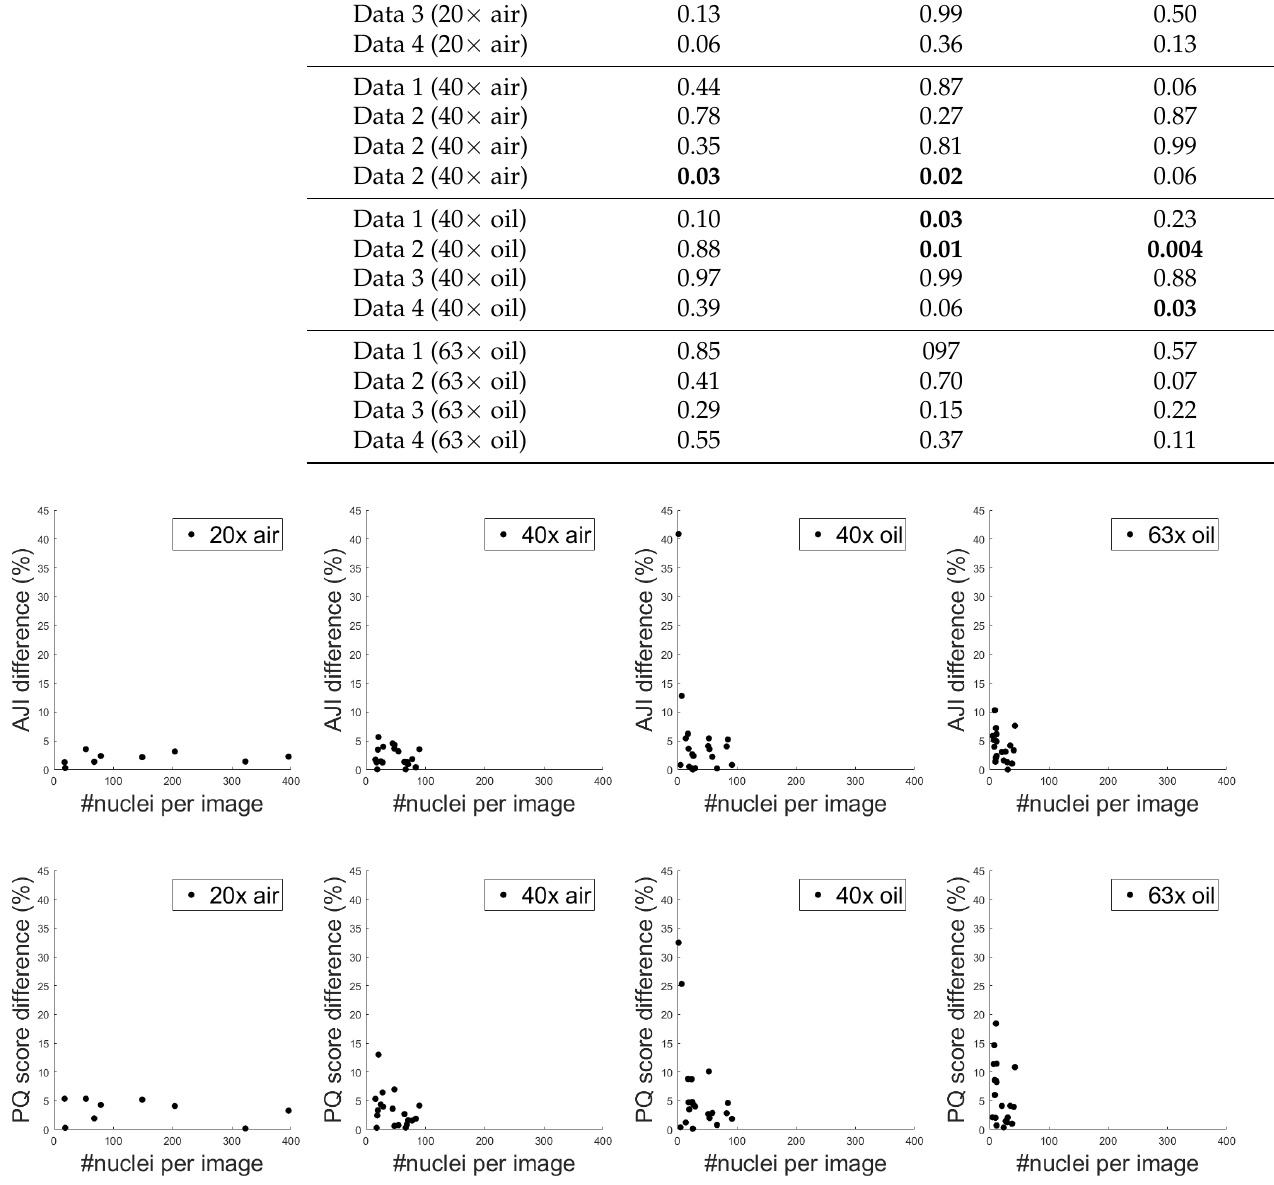
Figure 4. Differences between the AJI and PQ scores (%) for 8 bit and 16 bit images based on the number of nuclei in the images for different image magnifications in the BitDepth dataset. For each magnification, Dataset 4 was used to measure the performance differences between 8 bit and 16 bit